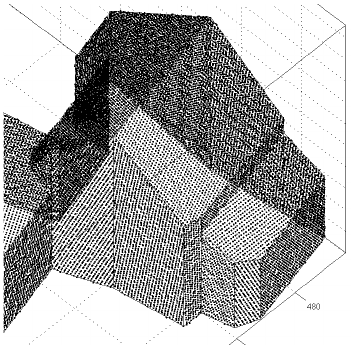
Figure 2: Detail of a point cloud obtained by airborne laser scan- ning and the derived generic polyhedral building reconstruction. Figure 3: Result of the point sampling for each face of the bound- ary representation (bird’s eye view) with sampling distance 20 cm and σ = 3 cm for each coordinate. The points of the bottom area have been omitted for